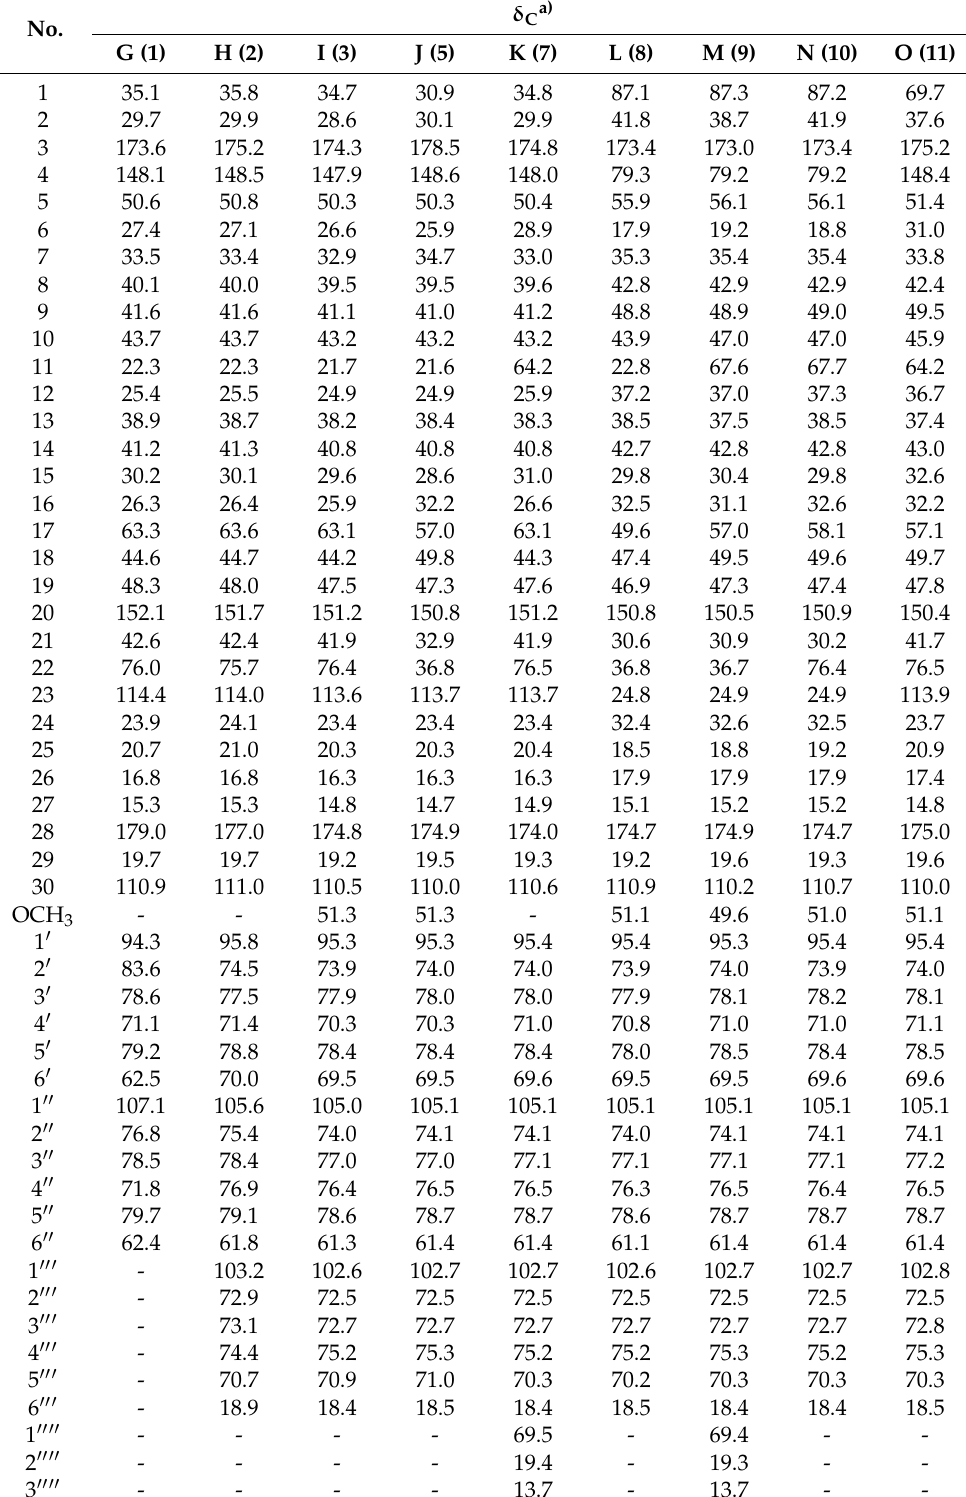
Table 2. 13 C-NMR data of acanthosessilioside